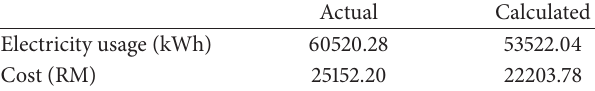
Table 6: Actual and calculated electricity usage and cost.